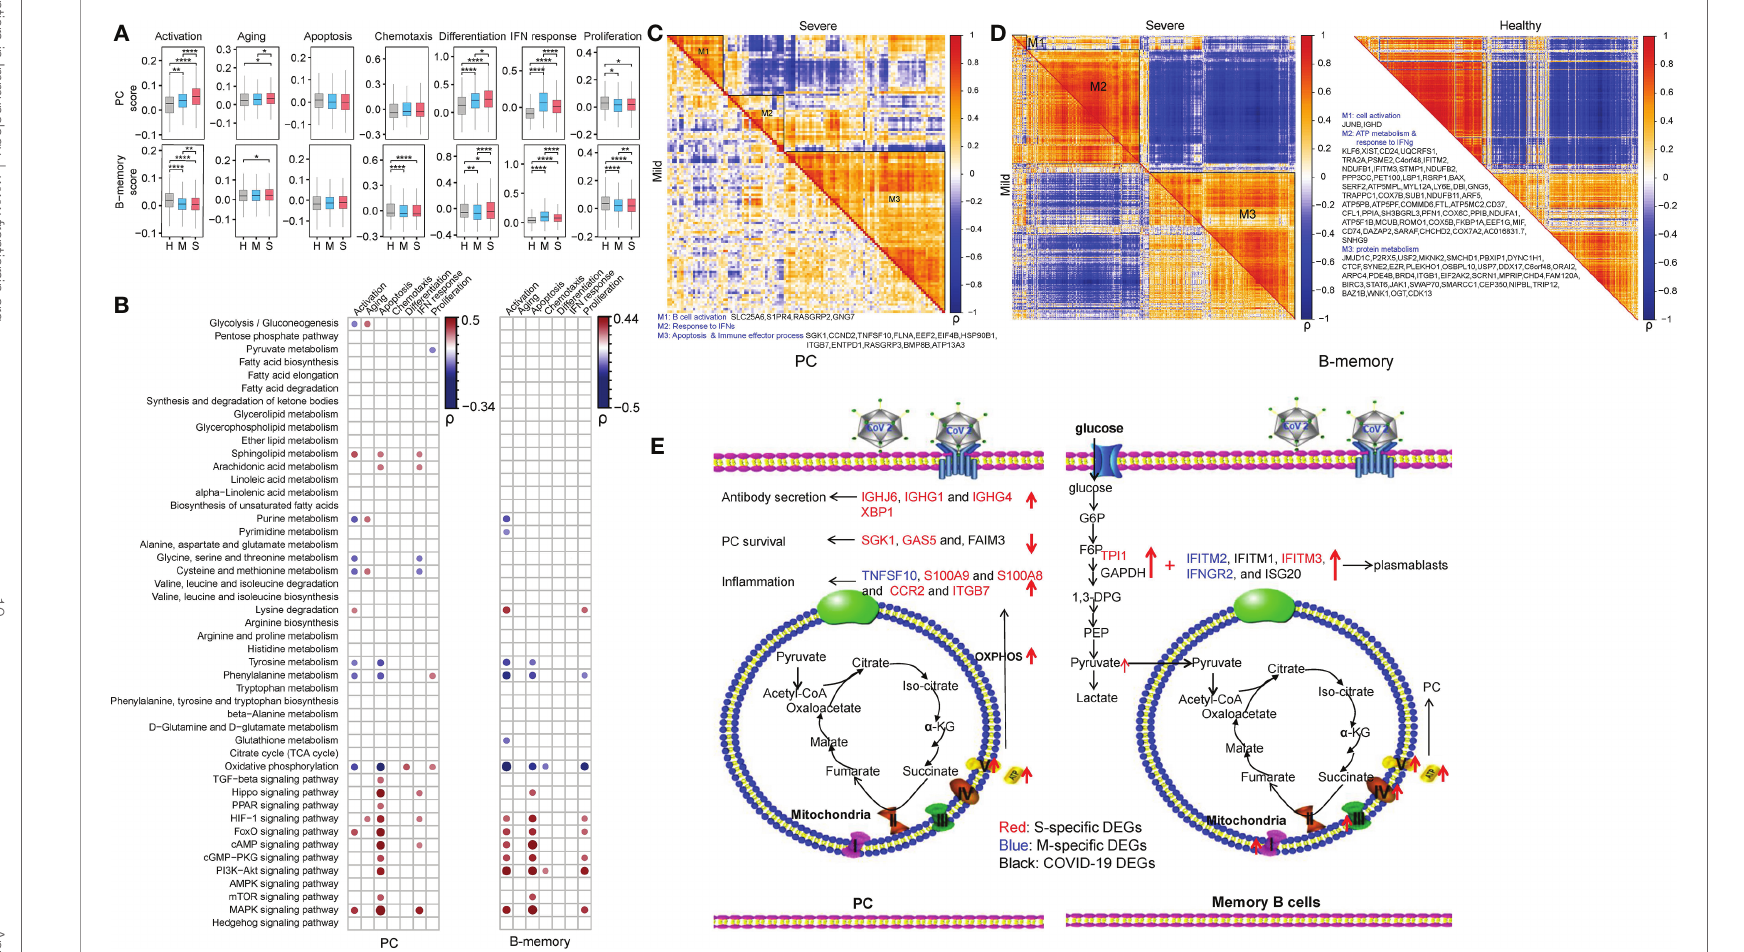
FIGURE 4 | Metabolic rewiring correlate with the differentiation, immunoglobin secretion and survival of PCs and for the differentiation of memory B cells in COVID-19 patients. (A) The selected functional changes in PCs and memory B cells in COVID-19 patients (Student ’ s t-test; * P < 0.05; ** P < 0.01; **** P < 0.0001); H, healthy control; M, patients with mild COVID-19; S, patients with severe COVID-19. (B) The Pearson correlations between the scores of B cell function and metabolic processes and signaling pathways in PCs (left panel) and memory B cells (right panel) of COVID-19 patients. “ r ” indicates the Pearson correlation coef fi cient; only dots representing correlations with | r | > 0.15 and P < 0.05 are shown. (C, D) Coexpression modules of DEGs in PCs and memory B cells in COVID-19 patients. The metabolism-related genes are marked. The coexpression modules in patients with mild and severe disease are shown in the lower triangle and upper triangle, respectively. “ r ” indicates the Pearson correlation coef fi cient. (E) The delineation of metabolism-immune response crosstalk in PCs and memory B cells in COVID-19 patients according to the DEGs and the KEGG pathways in which they participated. The S-speci fi c DEGs are shown in red. The M-speci fi c DEGs are shown in blue. The DEGs in COVID-19 patients are shown in